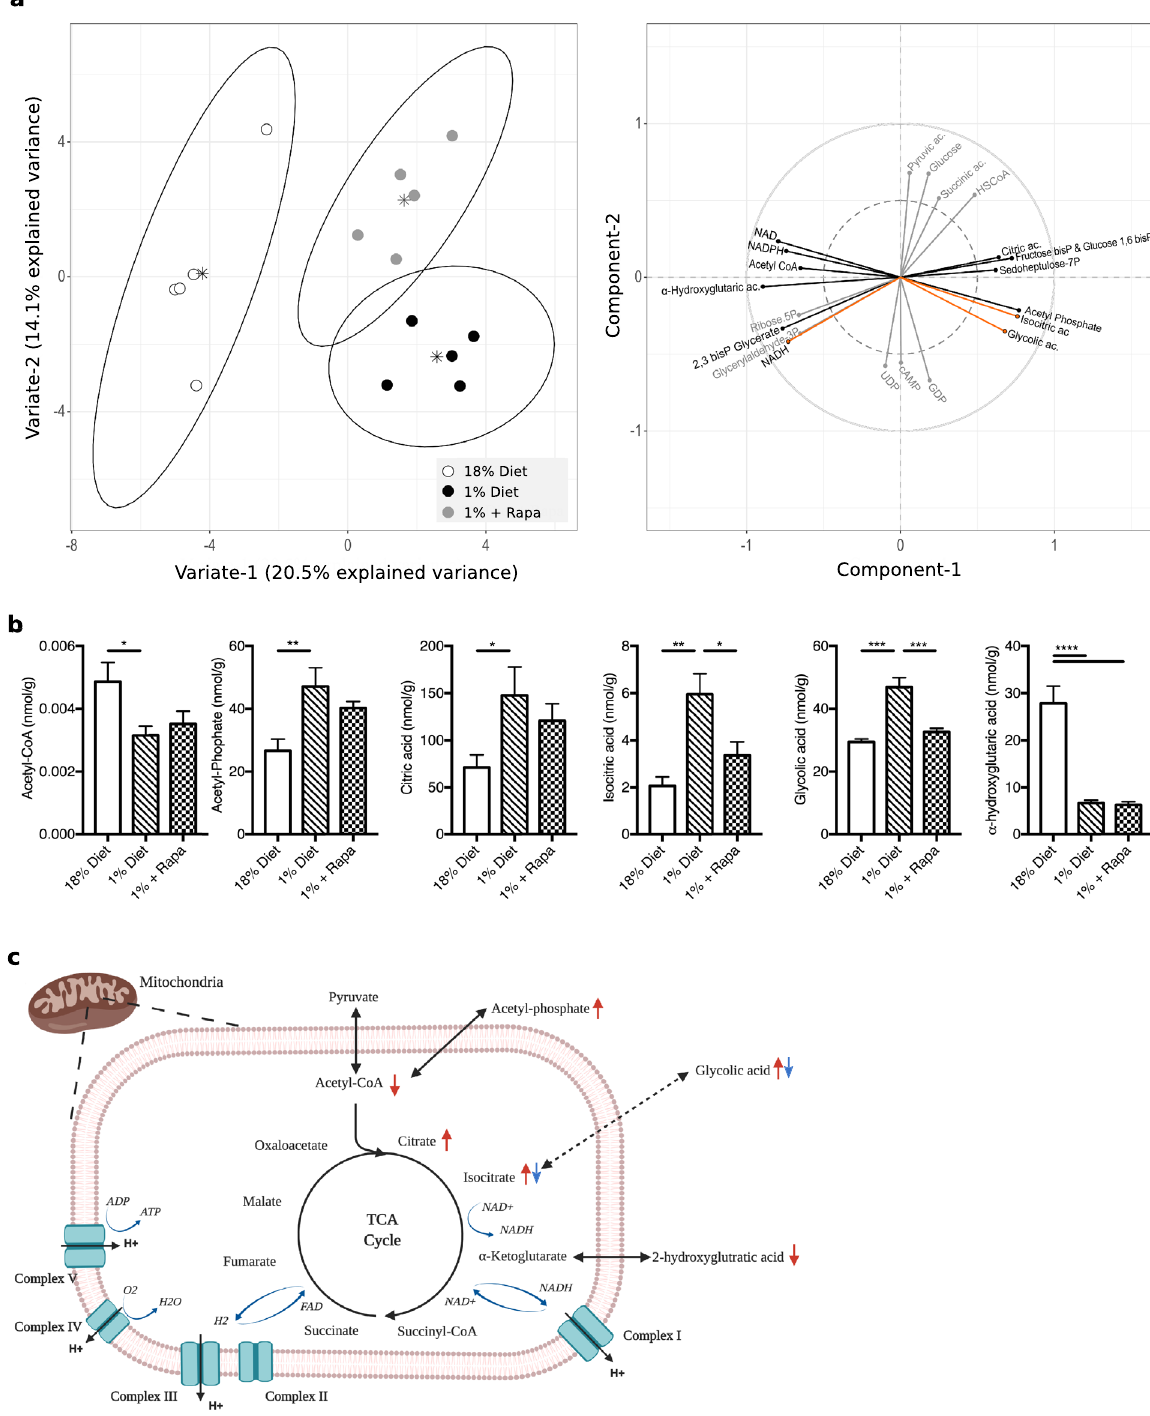
Figure 5. A low protein diet impairs the TCA cycle, which is in part prevented by rapamycin treatment. ( a ) Left panel, score plot of PLS-DA showing group separation based on all measured metabolites (groups coded as per legend); Right panel, correlation plot presenting the relationships between the top distinctive metabolites (VIP > 1); the metabolites that significantly contribute to component-1 (i.e., control vs. low protein fed) are indicated with black lines, those in grey show metabolites that only contribute to component-2 (i.e., difference between rapamycin treated vs. untreated low protein fed animals); while metabolites that contribute to both component-1 and -2 are indicated by orange lines. ( b ) Bar plots presenting mean and SEM of selected top metabolites that most discriminate between groups, nmol/g. n = 5. ( c ) Schematic overview of the changes in metabolites seen in the low protein fed-mice, red arrow indicating the increase or decrease in metabolites compared to control mice, and blue arrow compared to rapamycin. * p < 0.05, ** p < 0.005, *** p < 0.0005, **** p <